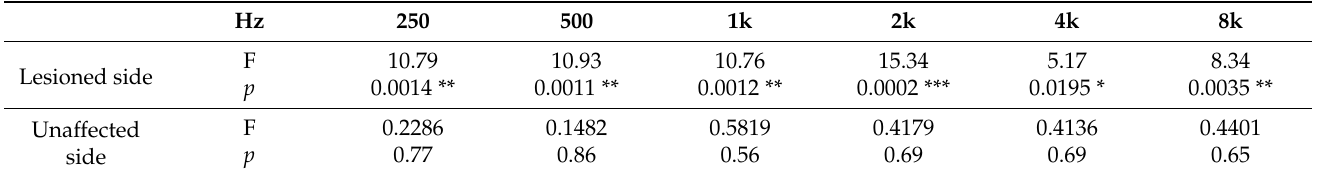
Table 3. Analysis (ANOVA) of each frequency for the lesioned and unaffected ears before treatment (T0), 1 month after treatment (T1), and 3 months after treatment (T3). * p < 0.05. ** p < 0.01. *** p <